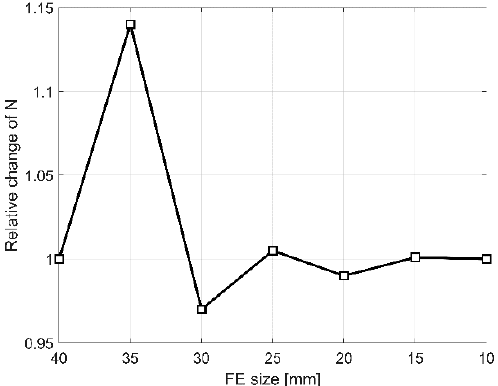
Figure 9. Convergence of the numerical model in terms of relative change of maximum load.